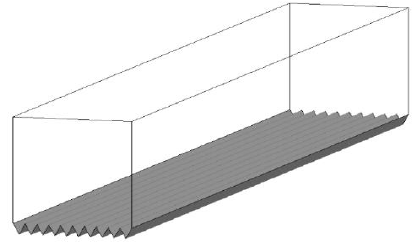
Figure 4. Triangular groove plate model.